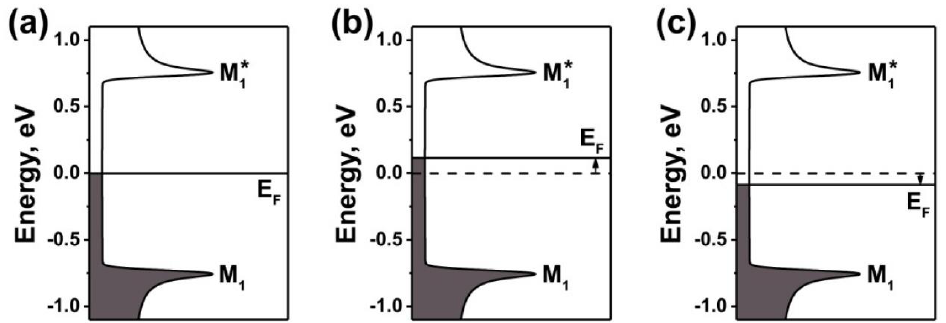
Figure 14. The schematics of the band structures of metallic SWCNTs (E F is the Fermi level and M 1 , and M 1 * are van Hove singularities) ( a ), upshift ( b ), and downshift ( c ) of the Fermi level of treated